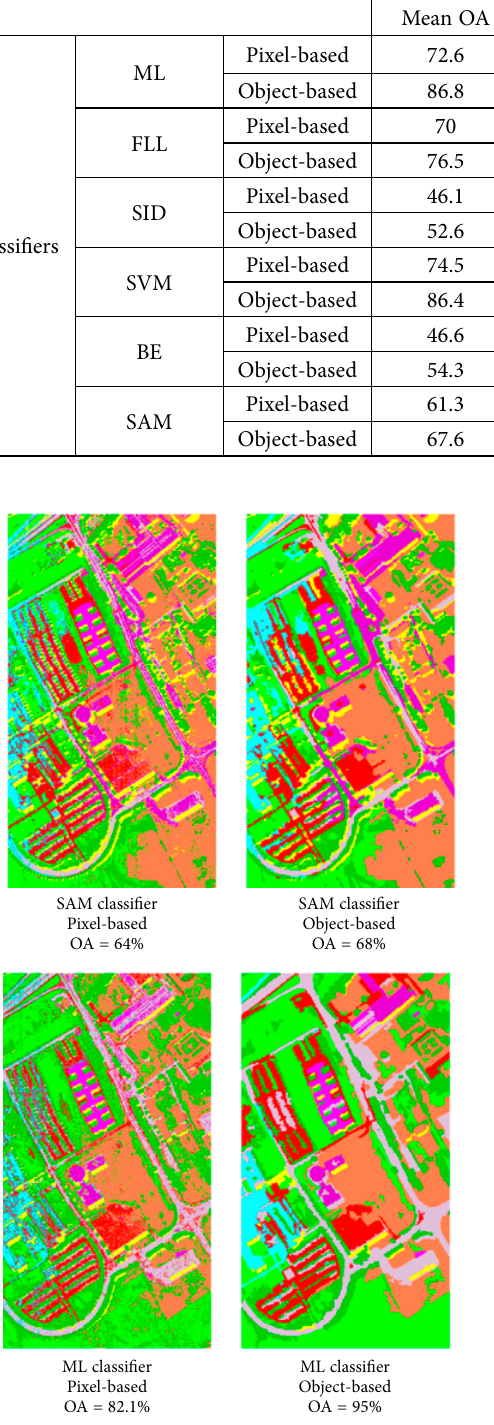
Fig. 6. Visual comparison of pixel and object-based classification of MNF features